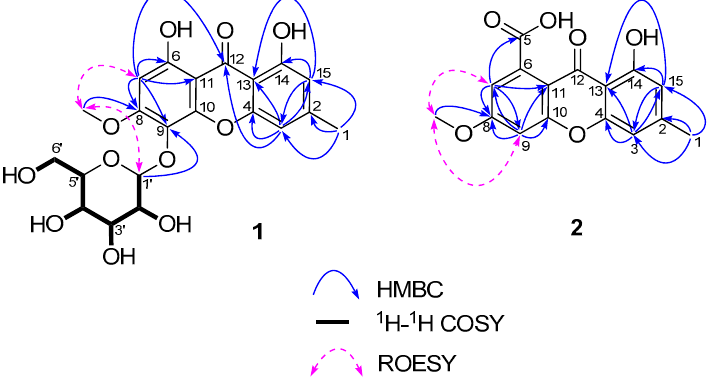
Figure 1. Key 1 H- 1 H COSY, HMBC and ROESY correlations of 1 and 2 .